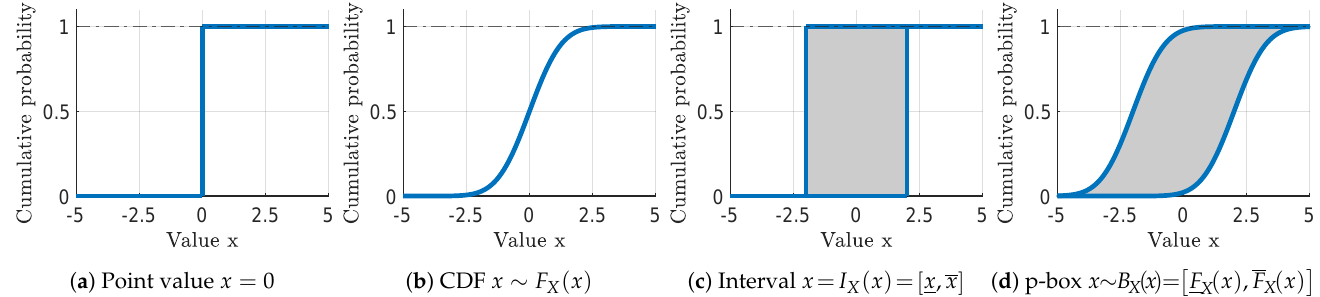
Figure 2. Types and notation of uncertainty based on Riedmaier et al.